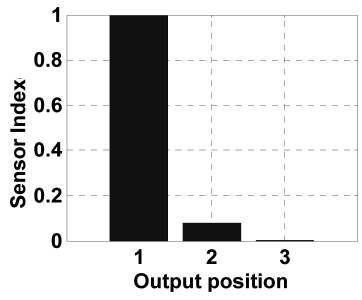
Fig. 7. Sensor index calculated using Eq. (10) for each of the sensor positions – experiments. Damage was simulated by adding 16 g mass at position 1. This should be compared with Fig. 3a, in which, the output position 1 corresponds to sensor position 1, output position 2 corresponds to sensor position 4 and output position 3 corresponds to sensor position 8.